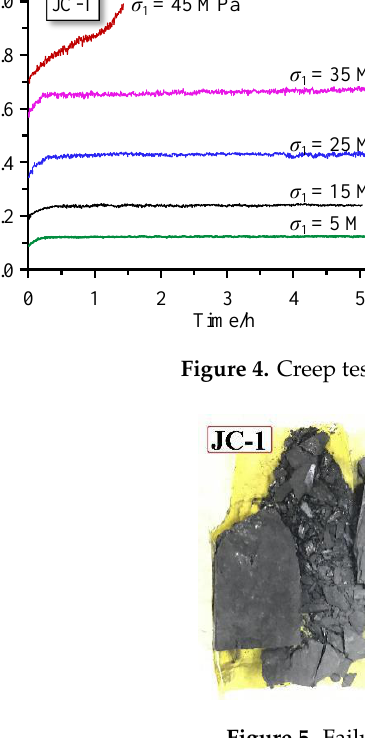
Figure 5. Failure characteristics of coal specimens